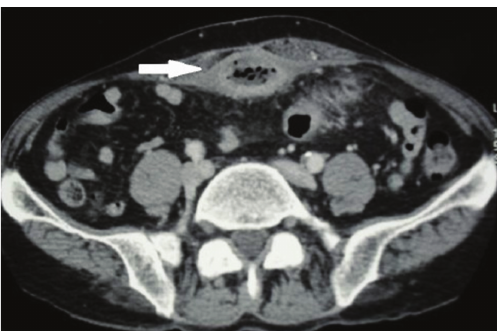
Figure 1: CT showed an air-fluid collection in the urachus (white arrow).